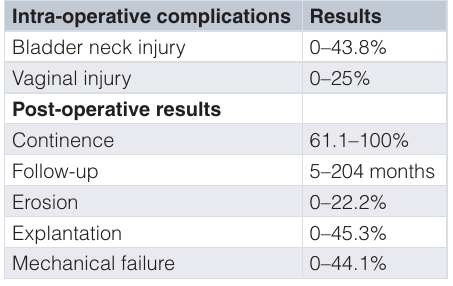
Table 5. Results and complications of artificial urinary sphincter in